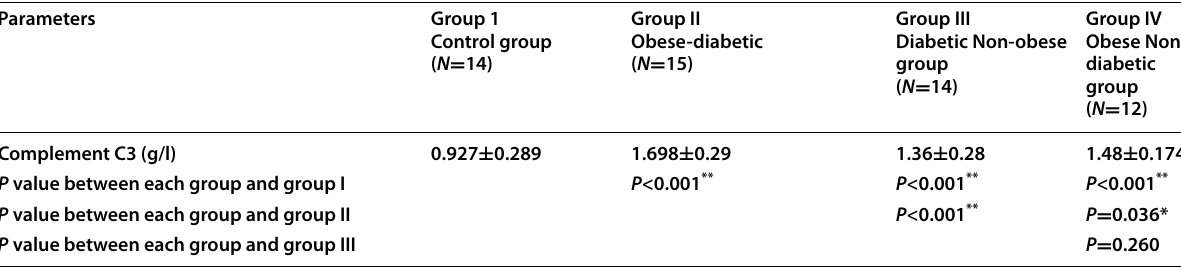
Table 2 Complement C3 levels in the all studied cases